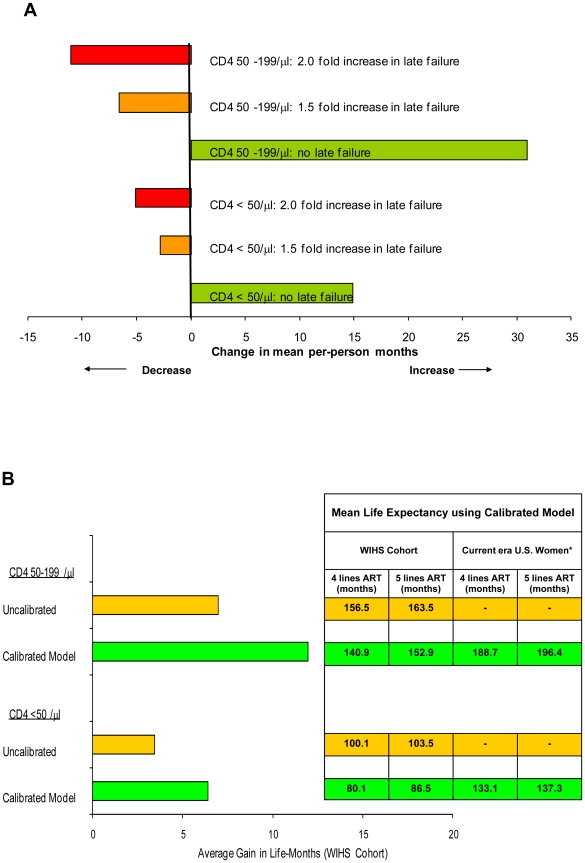
Impact of alternative assumptions on life expectancy.Results from sensitivity analyses showed that the most influential variable on long-term outcomes was the probability of late treatment failure. Part A of Figure 3, shows the impact of varying our base case assumptions (0.021) from no late failure to a 2-fold increase in late failure. Depending on the baseline CD4 cell count, life-expectancy was increased by 14.8 to 30.9 months with no late failure (green), and was decreased by 2.8 to 6.6 months with 1.5-fold increase in late failure (orange), and by 5.1 to 11.0 months with a 2-fold increase in late failure (red). The magnitude of these changes was similar regardless of whether we assumed 4 lines or 5 lines of HAART. Part B of Figure 3 shows the impact of 5 lines of HAART versus 4 lines of HAART on life expectancy. The average life expectancy projected by the model calibrated to the 24-month short-term data (using the mean of the 50 best-fitting sets) was 140.9 months (range, 130.5-148.4 months) among the patients with CD4 50–199/µl and 80.1 months (range, 65.9–87.3 months) among those with CD4 <50/µl. Average life-expectancy projected by the uncalibrated model varied with different assumptions about the ART effect, ranging from 123.3 months (no ART effect) to 156.5 months (ART effect) in patients with CD4 50–199/µl, and from 73.2 months (no ART effect) to 100.1 months in patients with CD4 <50/µl (ART effect). Figure 3, Part B, shows the incremental gains provided by 5 lines of HAART versus 4 lines of HAART were greatest using the calibrated model (green bars), and lowest using the uncalibrated model assuming no ART eff ect (orange bars).